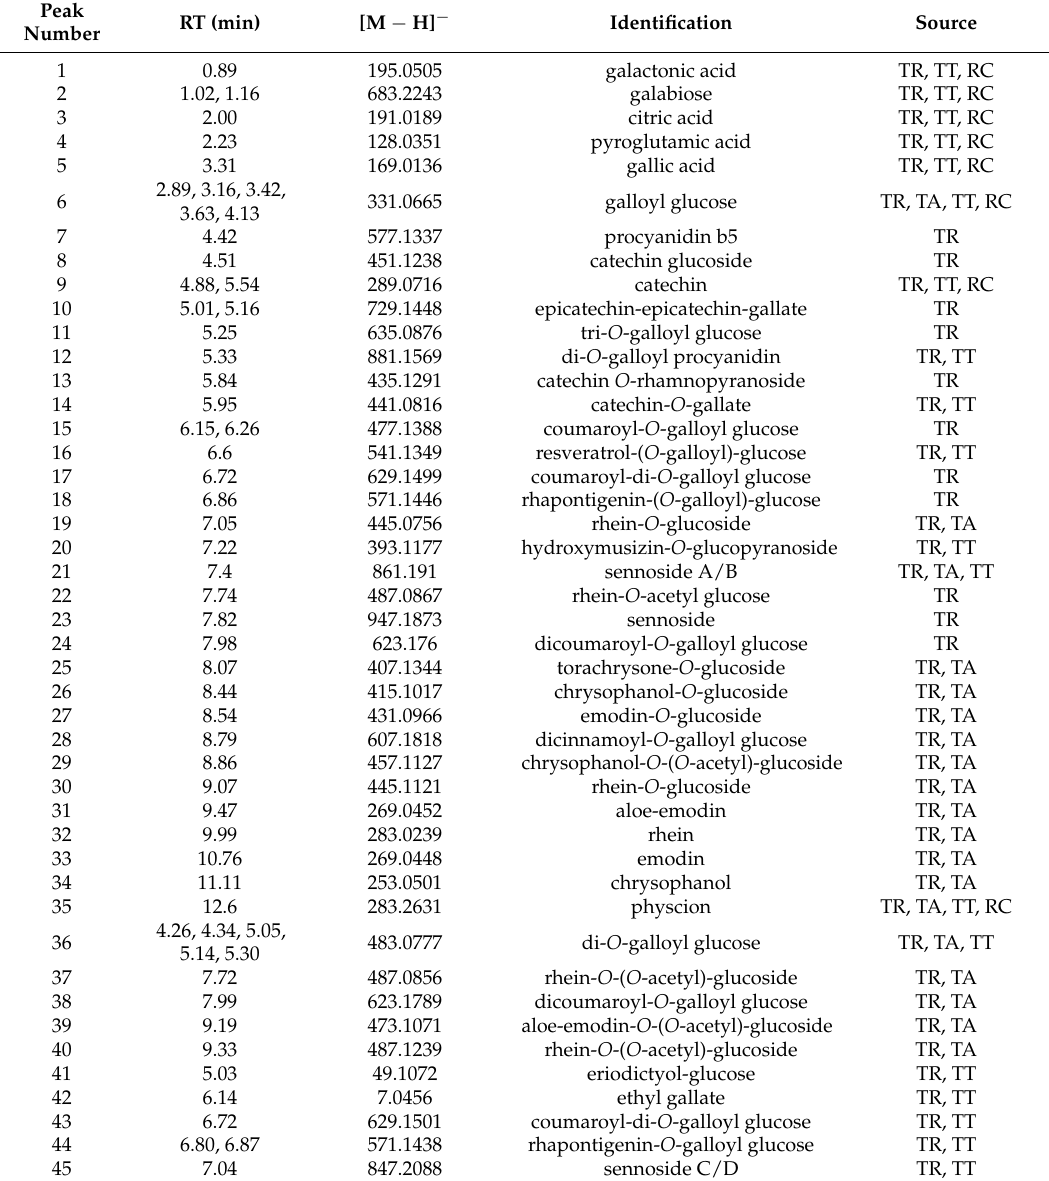
Table 2. Identifications for the chromatographic